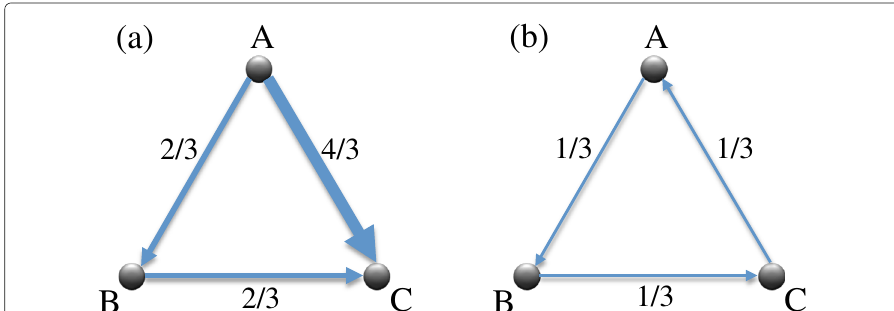
Fig. 2 Gradient flow component ( a ) and circular flow component ( b ) of the triangular network as shown in Fig. 1c, according to the Helmholtz-Hodge decomposition